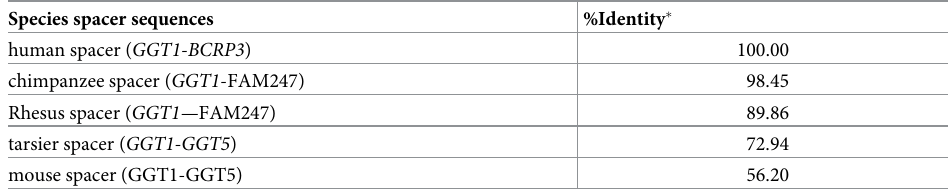
Table 1. GGT1 -associated spacer sequences and percent identity between